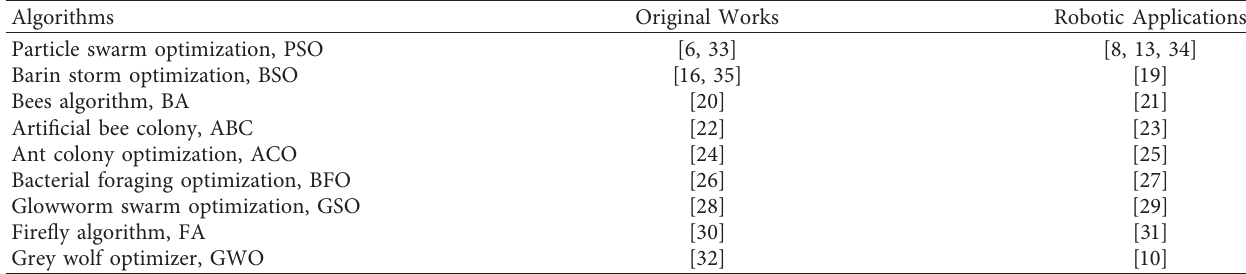
Table 2: SI algorithm inspired robotic